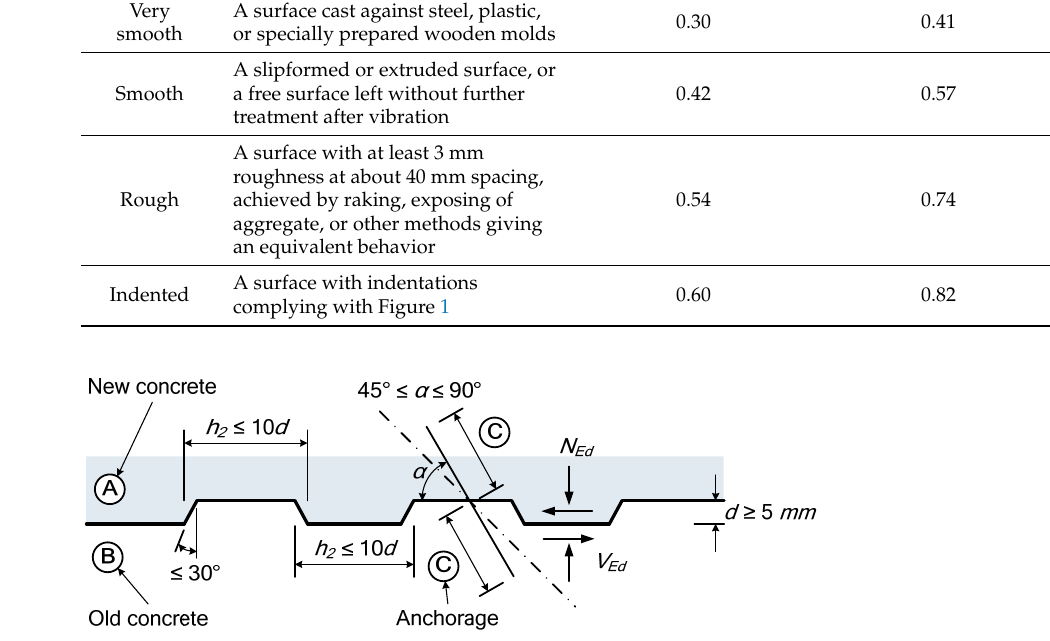
Figure 1. Indented construction joint [26].